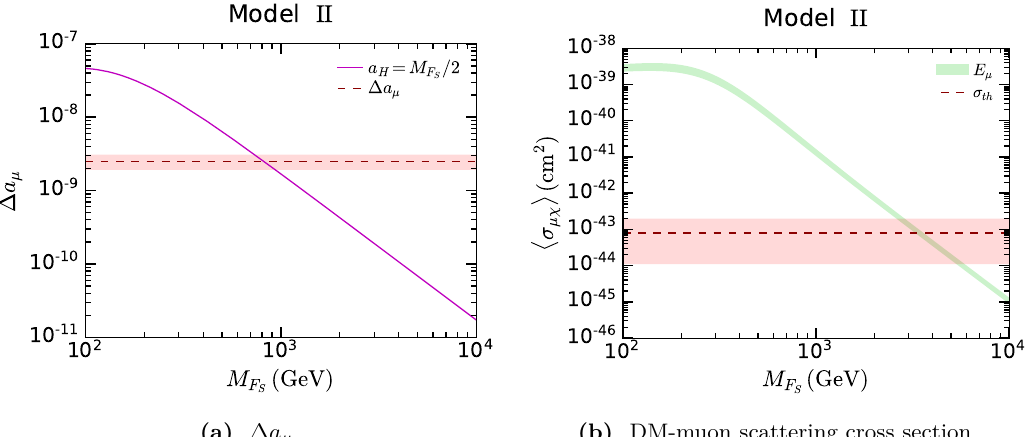
Figure 9. The DM-muon scattering cross sections as functions of (a) the DM mass M χ (b) y 1 H . The rest of the parameters are fixed as per in figure 6. E µ is varied in the range [ m µ , m µ / B ( R NS )] for M NS = 1 . 5 M (cid:12) and R NS = 12 . 593 km and the resultant change in the cross section is indicated by the band. The horizontal red dashed line shows the threshold cross section p for muon, σ th ’ 8 × 10 − 44 cm 2 and the horizontal red band represents the variation of the threshold cross section due to the EoS uncertainty [129].